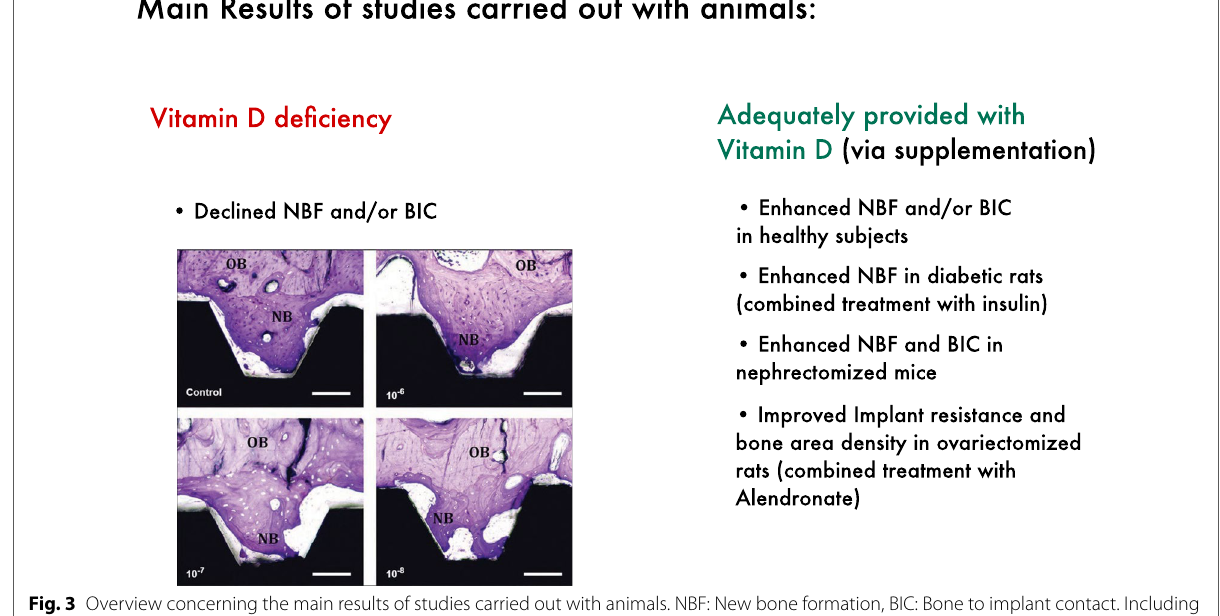
Fig. 3 Overview concerning the main results of studies carried out with animals. NBF: New bone formation, BIC: Bone to implant contact. Including histological pictures published by Naito et al. 2014 (https:// www. ncbi. nlm. nih. gov/ pmc/ artic les/ PMC42 19862/), no changes have been made to the Figure. Copyright © Naito Y, Jimbo R, Bryington MS, Vandeweghe S, Chrcanovic BR, Tovar N, Ichikawa T, Coelho PG, Wennerberg A. (http:// creat iveco mmons. org/ licen ses/ by‑ nc‑ nd/3.